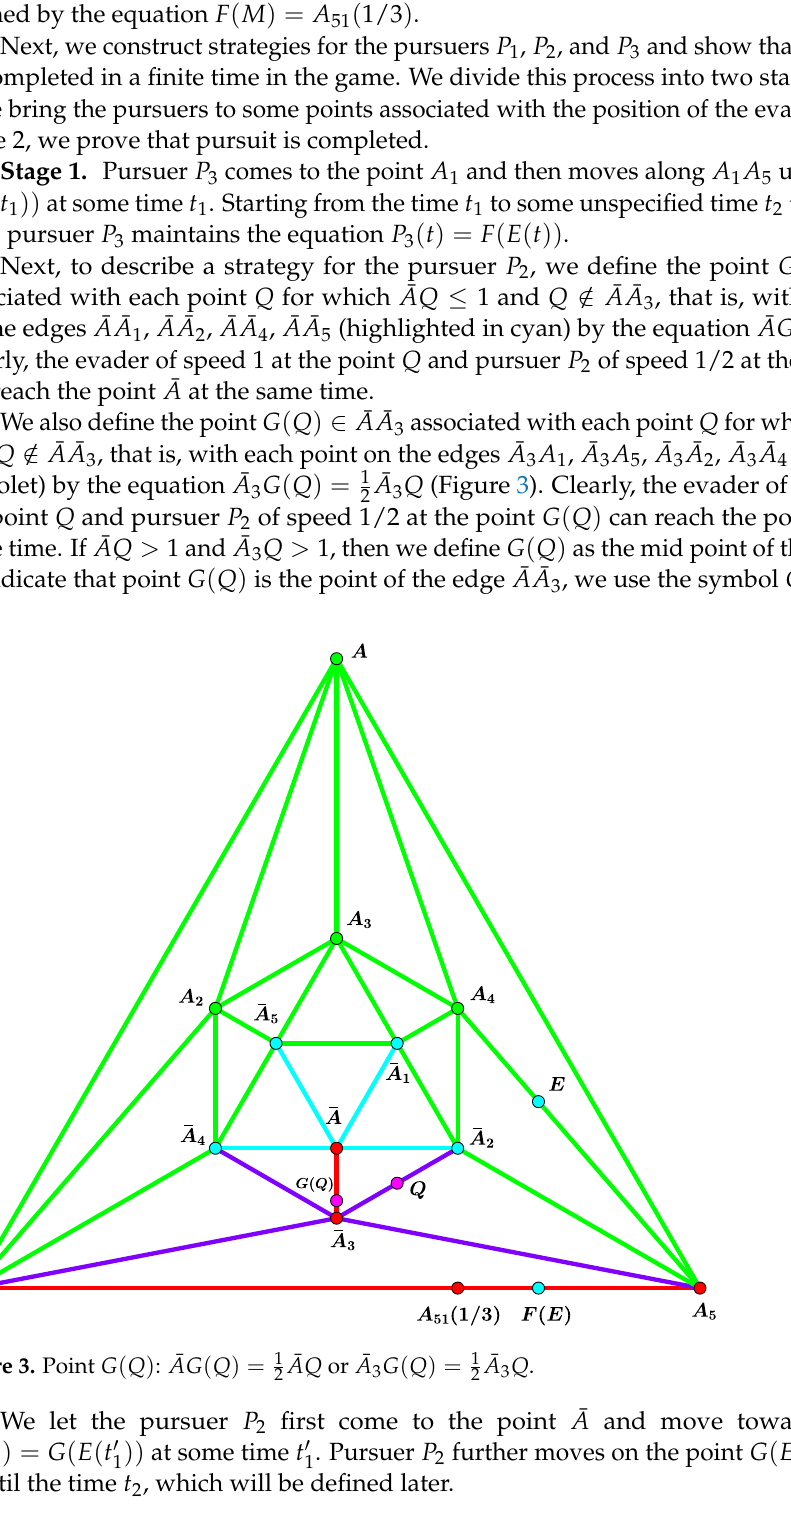
¯ A ( Q ) = 1 3 G 3 Q 2